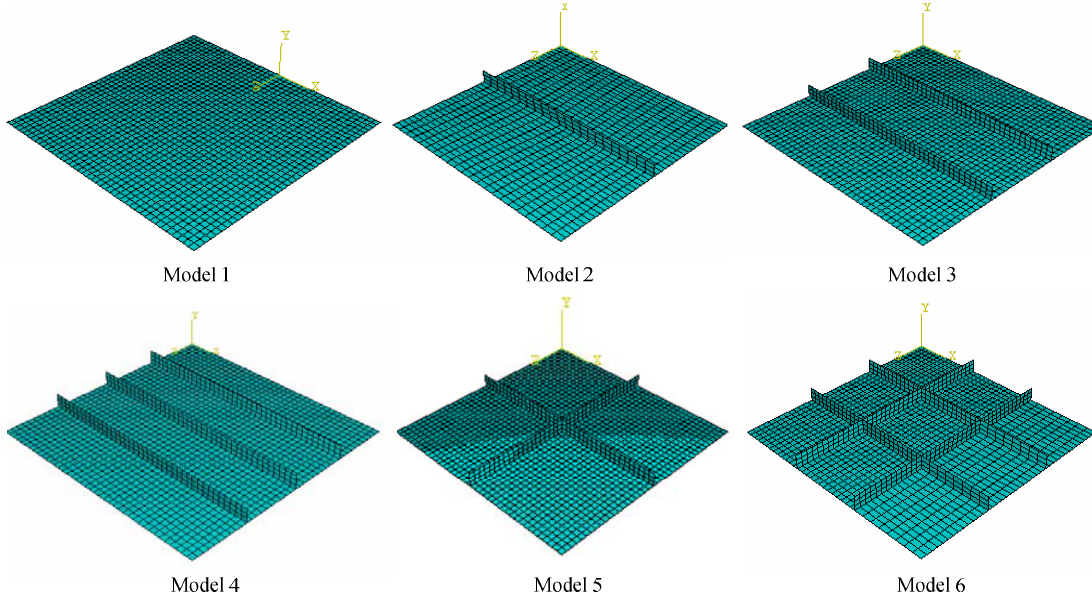
Fig. 1. Configurations of